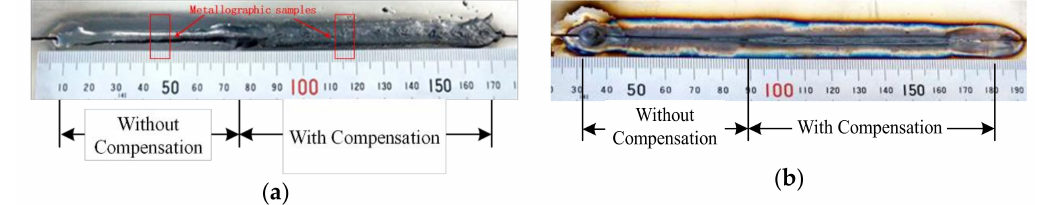
Figure 5. Weld bead shape of sample 1#: ( a ) Front view; ( b ) back